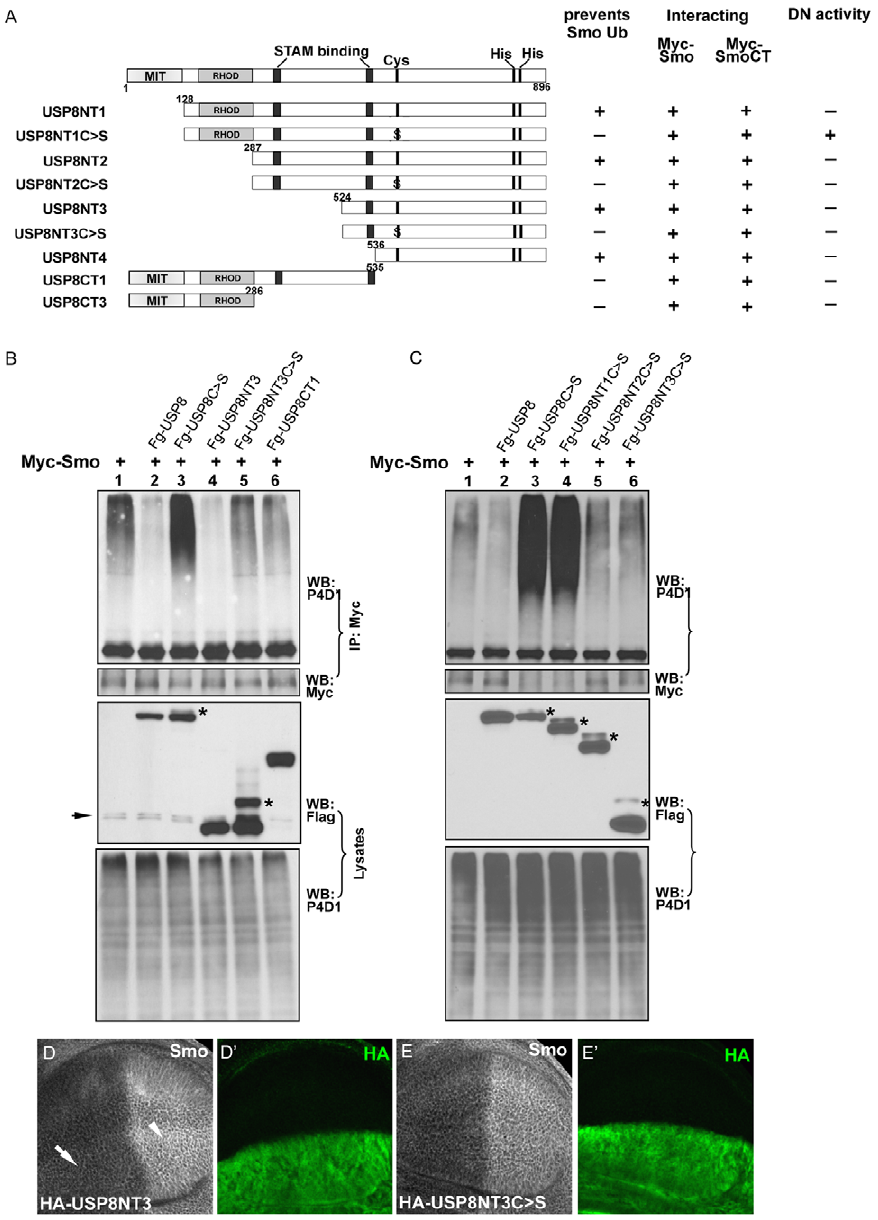
Figure 8. The deubiquitinase activity of USP8 variants. (A) A diagram of the USP8 protein and deletion constructs. The interaction between Smo and USP8 was determined by immunoprecipitation experiments shown in Figure S2. The activity of each USP8 construct was assessed in S2 cells by their ability to regulate the levels of Smo ubiquitination (shown below). MIT, microtubule interacting and transport domain; RHOD, Rhodanese homology domain. (B) S2 cells were transfected with Myc-Smo and the indicated USP8 constructs followed by the immunoprecipitation assay to detect Smo ubiquitination. The expression of USP8 variants was detected by a Western blot of lysates with an anti-Flag antibody (lower-middle panel). The arrow indicates a non-specific band and the asterisks indicate a possible modification of USP8C . S or USP8NT3C . S. USP8NT3C . S and USP8CT1 did not regulate Smo ubiquitination (lanes 5 and 6, top panel). (C) The effects of USP8 mutants on Smo ubiquitination were examined in S2 cells by the immunoprecipitation assay. The asterisks indicate a possible modification of USP8. Of note, both USP8C . S and USP8NT1C . S have dominant negative effects on Smo ubiquitination (lanes 3 and 4, top panel), whereas USP8NT2C . S and USP8NT3C . S do not (lanes 5 and 6, top panel). (D–E 9 ) Wing discs expressing USP8NT3 or USP8NT3C . S by ap -Gal4 was immunostained for Smo and HA. The arrow and arrowhead in (D) indicate elevated Smo accumulation in A- and P-compartment cells. Notably, expression of USP8NT3C . S has no effect on Smo accumulation. doi:10.1371/journal.pbio.1001238.g008 from the A/P boundary (Figure 7I–J). We also examined the accumulation in wing discs (Figure 8E–E 9 ) or on GFP-Smo activity activity of USP8 mutants that contain the Cys572Ser mutations. (unpublished data). These data suggest that the MIT and RHOD Both USP8C . S and USP8NT1C . S had dominant negative domains are required for USP8C . S to act in a dominant negative effects, but USP8NT2C . S and USP8NT3C . S did not manner. We further examined the subcellular localization of USP8 (Figure 8C). In addition, USP8NT3C . S had no effect on Smo variants and found that USP8C . S and USP8NT1C . S, but not